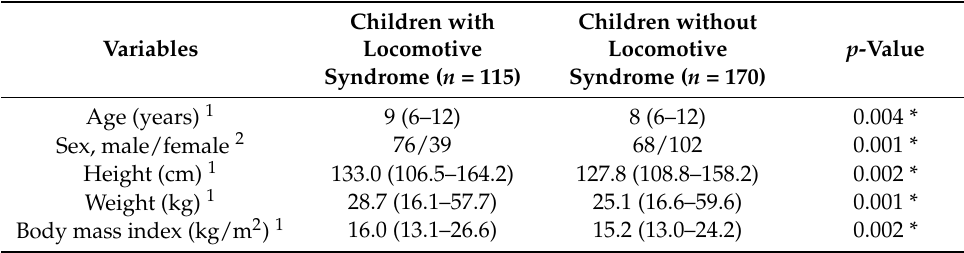
Table 1. Characteristics of Table 3. Multivariable analysis for factors associated with locomotive syndrome among the participants ( n = 285).